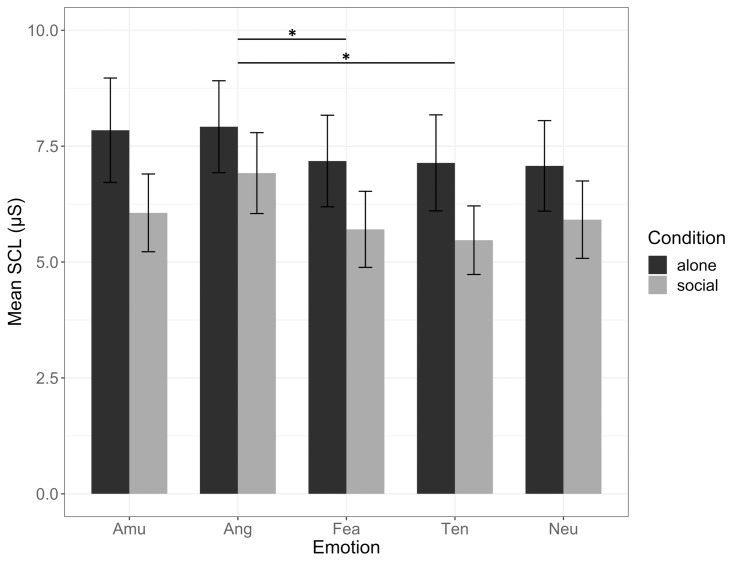
SCL values per emotion in both conditions.Error bars represent the standard error of the mean. Amu = amusement; Ang = anger; Fea = fear; Ten = tenderness; Neu = neutral; SCL = skin conductance level.